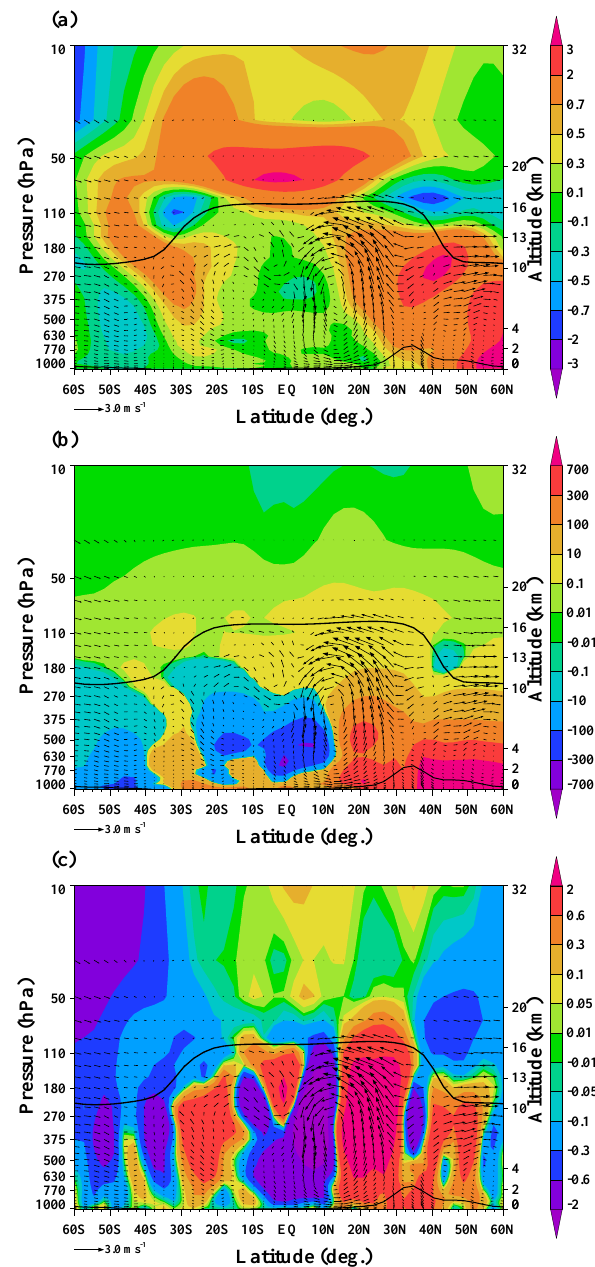
Fig. 10. Latitude–pressure structure (filled contours, averaged over 60–120 ◦ E) of difference between ECHAM5-HAMMOZ CTRL and NOAER runs during ASM for (a) temperature (K), (b) water vapour (ppmv), and (c) vertical wind (mms − 1 ; not scaled). The meridional circulation is shown as a vector field (the vertical ve- locity field has been scaled by 300 and the units are ms − 1